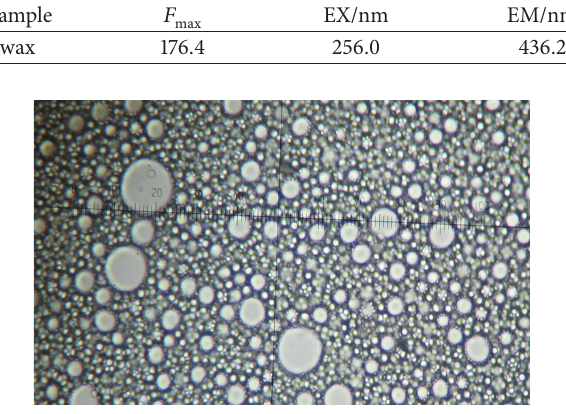
Figure 3: SEM images of the produced wax emulsion.